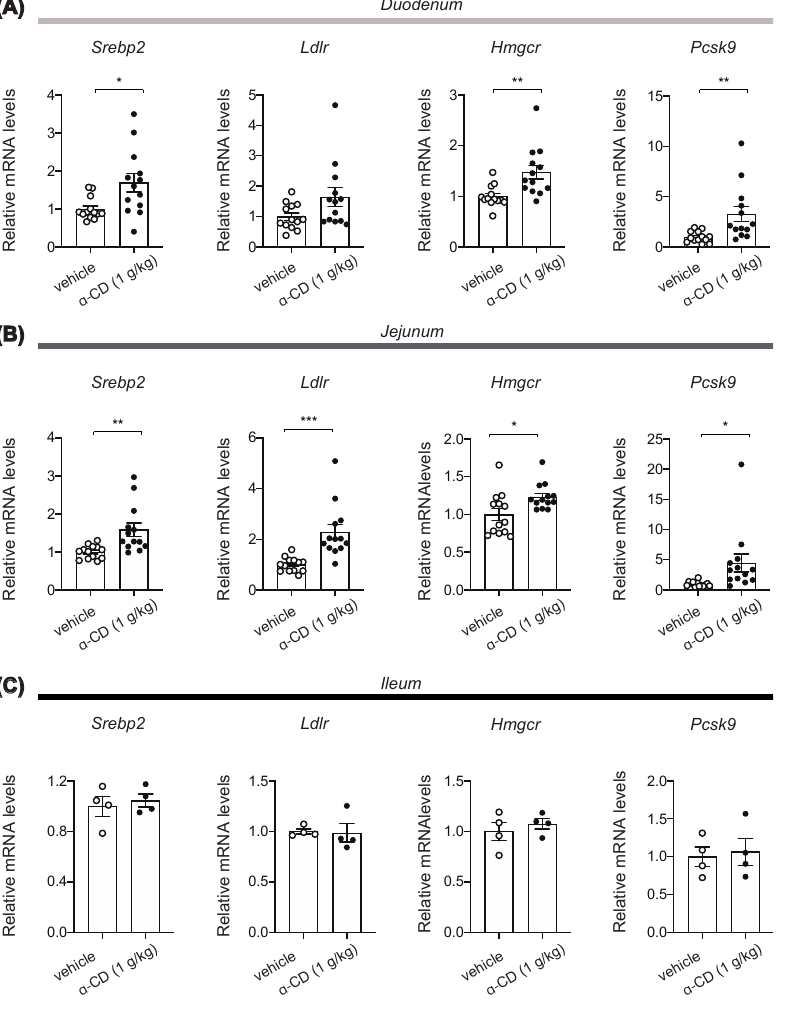
Figure 5. Induction of SREBP2 target gene expressions in small intestine by α‐ CD. ( A – C ) Effects of α‐ CD on mRNA expression of SREBP2 target genes ( Srebp2 , Ldlr , Hmgcr , and Pcsk9 ) in duodenum ( A ) ( n = 13–14), jejunum ( B ) ( n = 13–14), and ileum ( C ) ( n = 4). Bars depict mean ± SEM. Each data is plotted as a circle. * p < 0.05, ** p < 0.01, and *** p < 0.001 by unpaired ‐ Student t ‐ test.